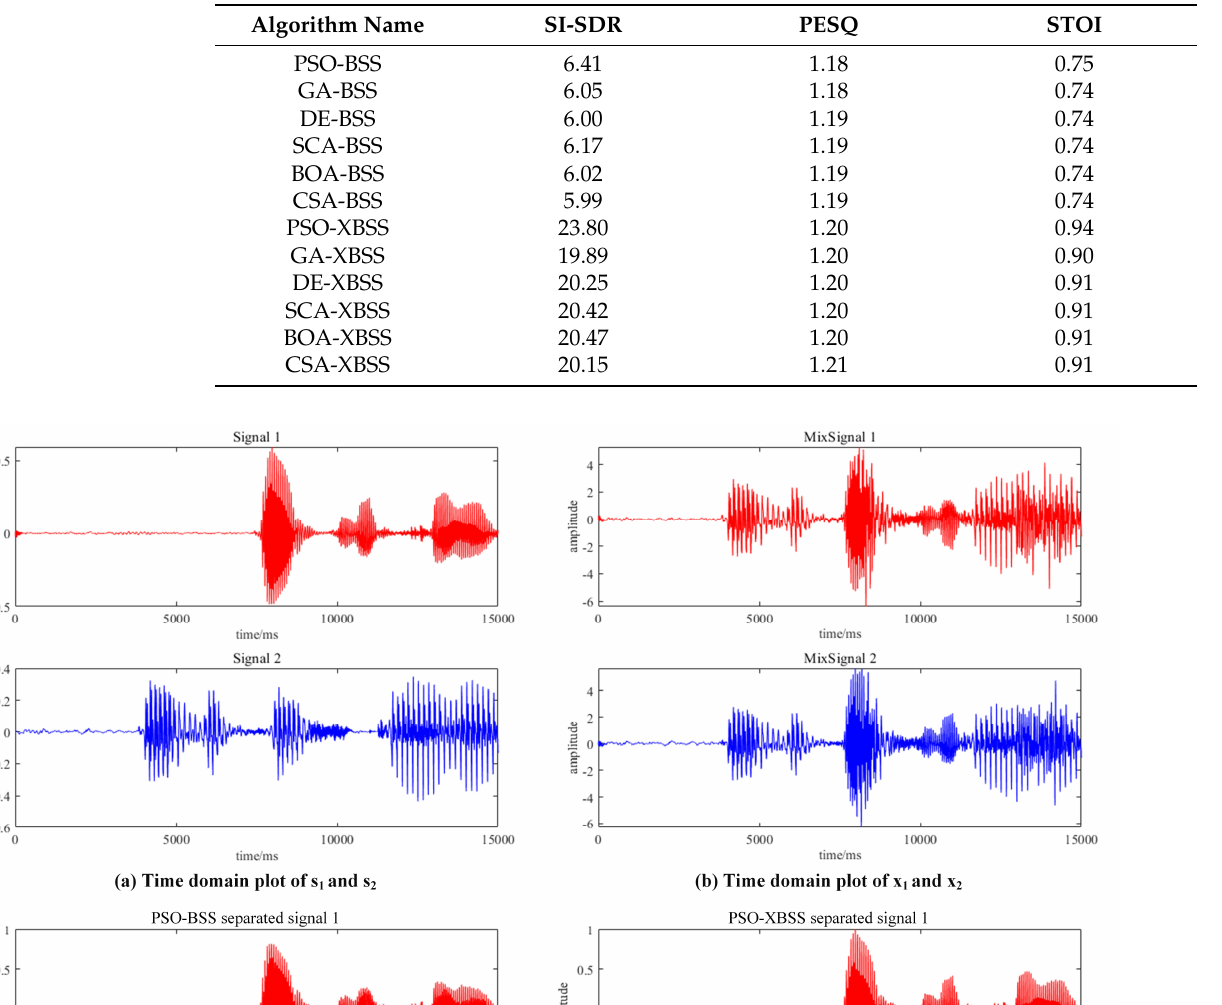
Table 2. The mean evaluation values of SI-SDR, PESQ, and STOI.